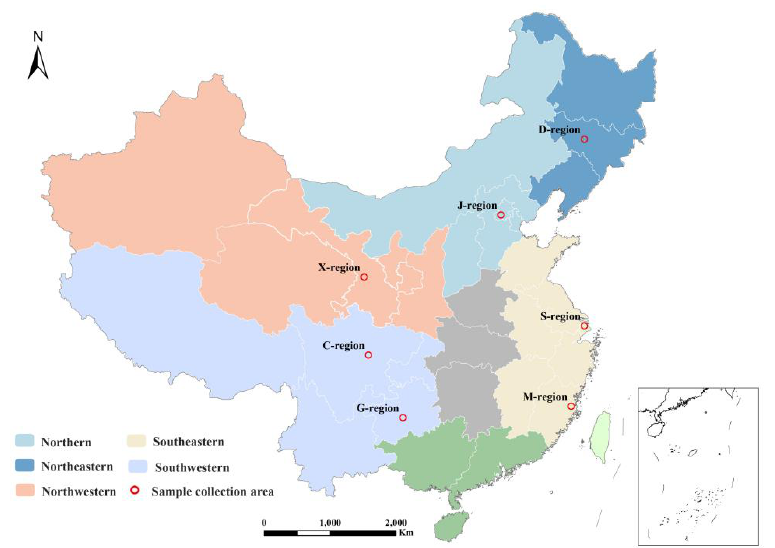
Figure 2. Distribution of sample collection sites. Note: Changchun represents Northeast China (D-region); Beijing and Tianjin represent North China (J-region); Lanzhou, Tongchuan and Qingyang represent Northwest China (X-region); Fuzhou and Shanghai represent Southeast China (M-region, S-region); Guiyang and Chengdu represent Southwest China (C-region, G-region). Table 1. Basic information for different sampling sites.